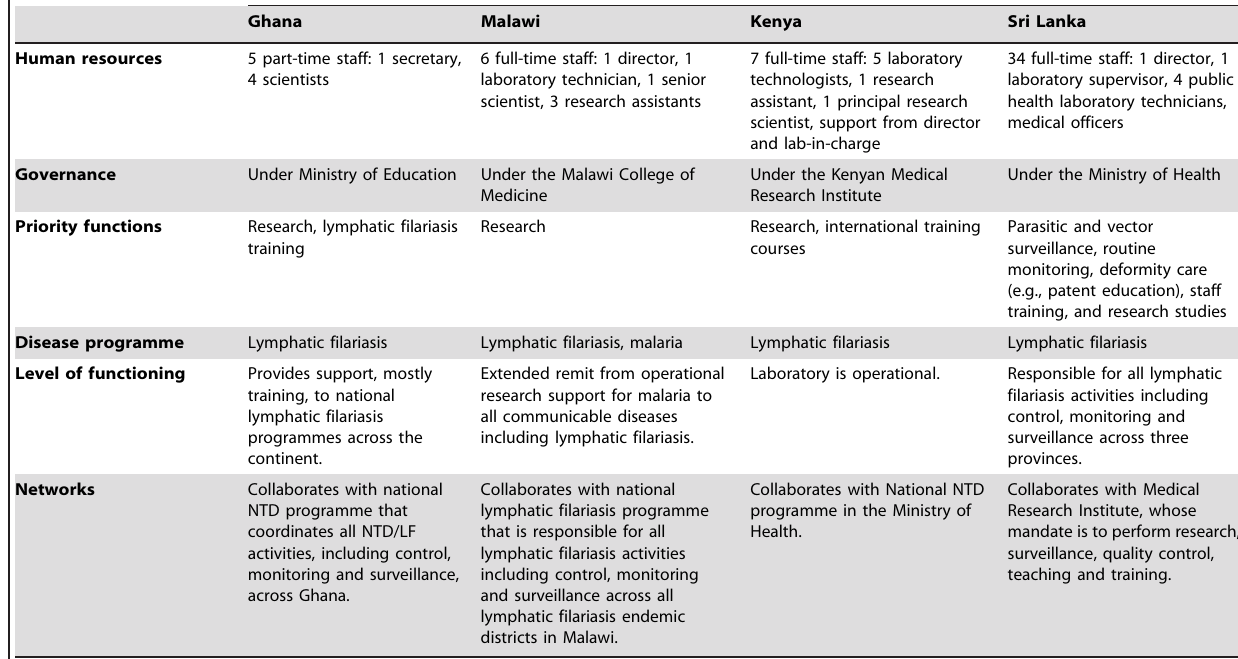
Table 3. Description of laboratories included in our